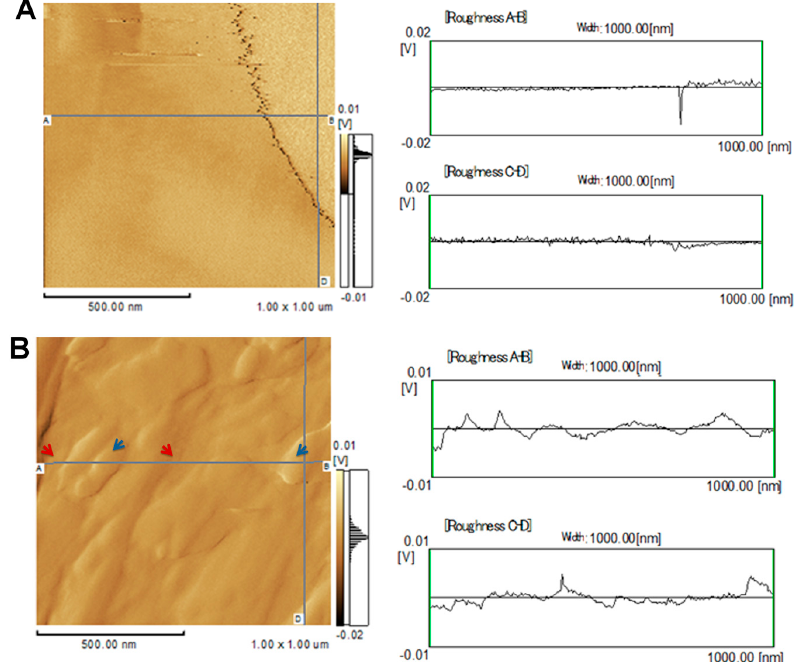
Figure 1. Cont. Figure 1.